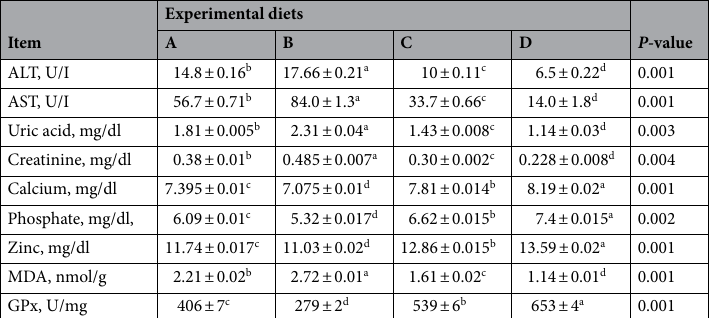
Table 4. Effect of DETOXIZYME supplementation on blood parameters under clostridia infection in Cobb 500 broilers. a–c The means values placed at the rows by different superscript letters are significantly different (P < 0.05). Values are expressed as means ± standard error. Abbreviations: (A) control negative (basal diet), (B) control positive (basal diet supplemented with clostridia infection), (C) control positive group diet with 100 g DETOXIZYME/ton of feed, (D) control negative diet group with 100 g DETOXIZYME/ton of